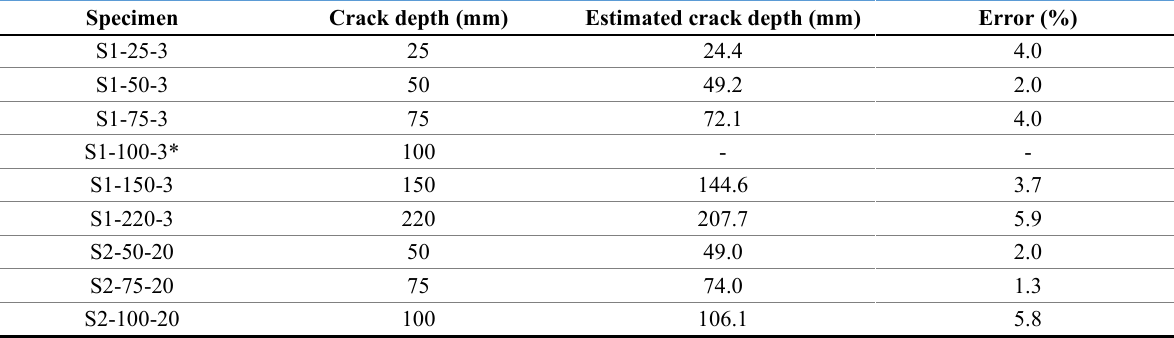
Table 2. Estimated crack depths by Method A [8]